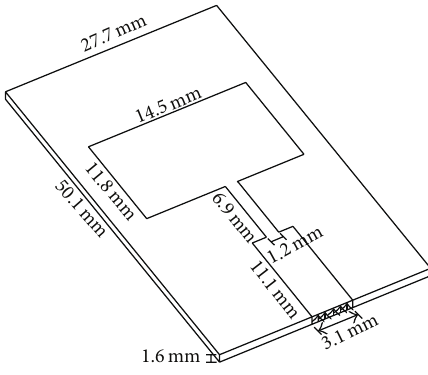
Figure 7: Geometry of the microstrip antenna.